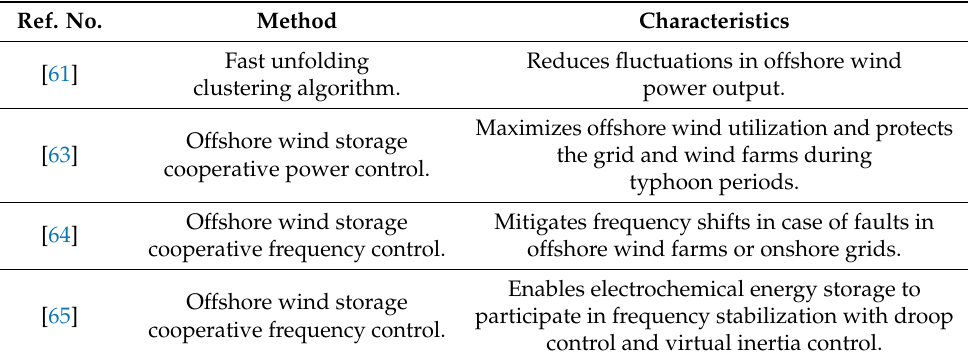
Table 2. Offshore wind storage integrated system control methods. Ref.